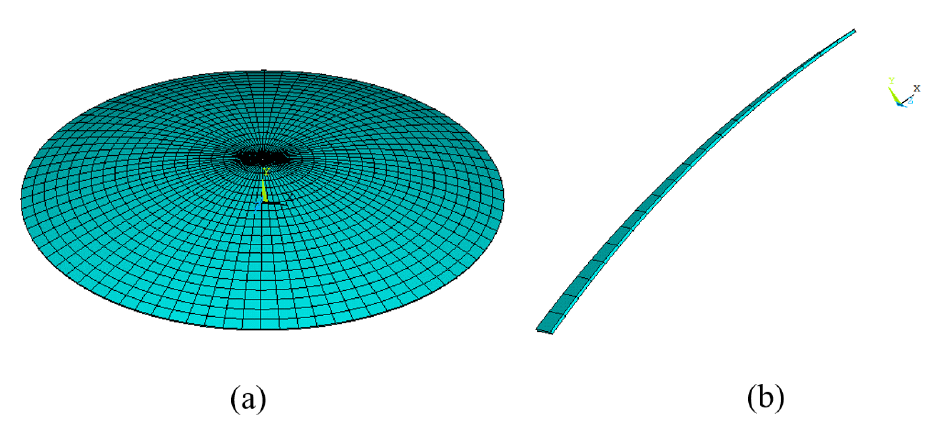
Figure 7. Cap discretization: ( a ) Whole model; ( b ) single meridian element selection. The caps were modeled using eight-node shell elements with 6 degrees of freedom for each node and quadratic shape functions. The axial forces and the bending moments acting on each shell element cross-section perpendicular to the parallels and meridians were